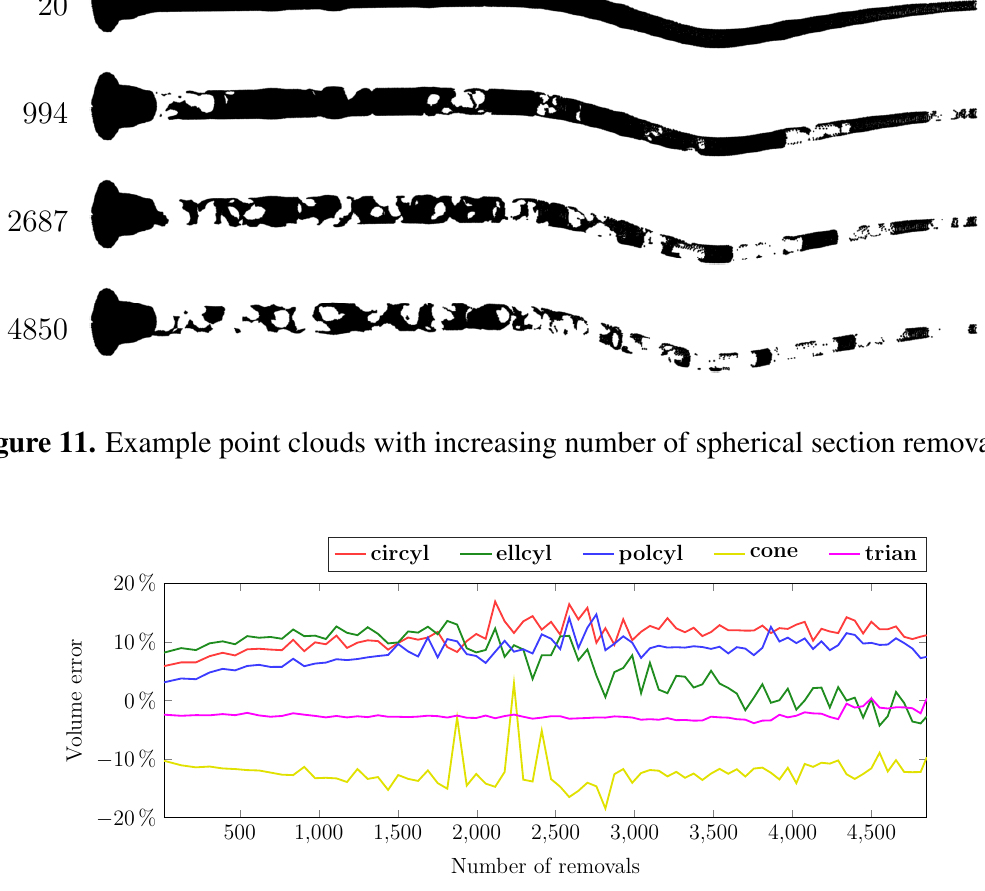
Figure 12. Effect of decreasing data quality on reconstructed volume. The horizontal axis represents the increasing number of spherical section removals from the point cloud scanned with the 0.036 sampling ◦